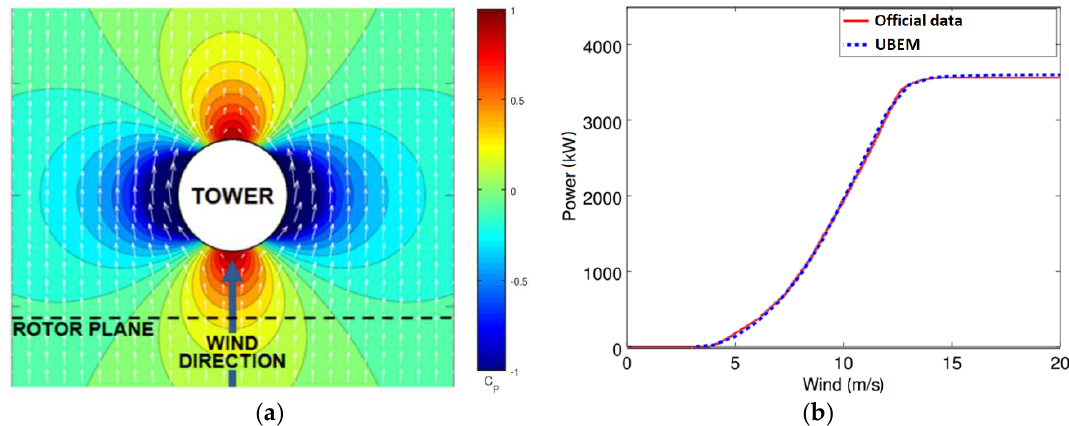
Figure 6. ( a ) Potential flow tower model with the colour bar indicating the dimensionless pressure coefficient ( C p ). ( b ) Comparison of wind power curves.